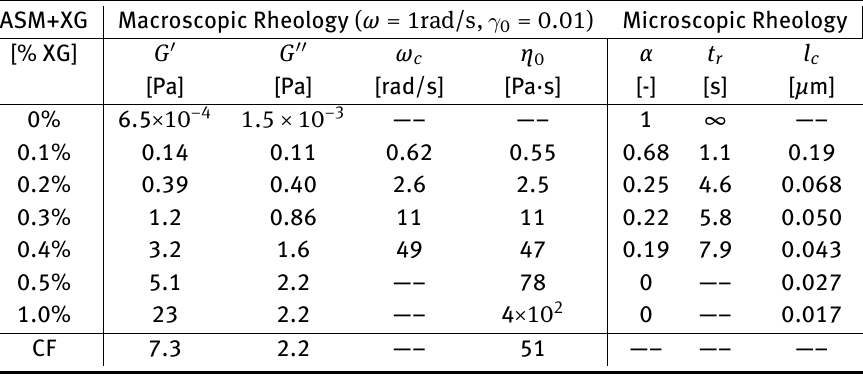
Table 2: Macroscopic and microscopic data of ASM, ASM+XG, and CF sputum [15]. ASM+XG Macroscopic Rheology ( ω = 1rad/s, 𝛾 0 = 0.01) Microscopic